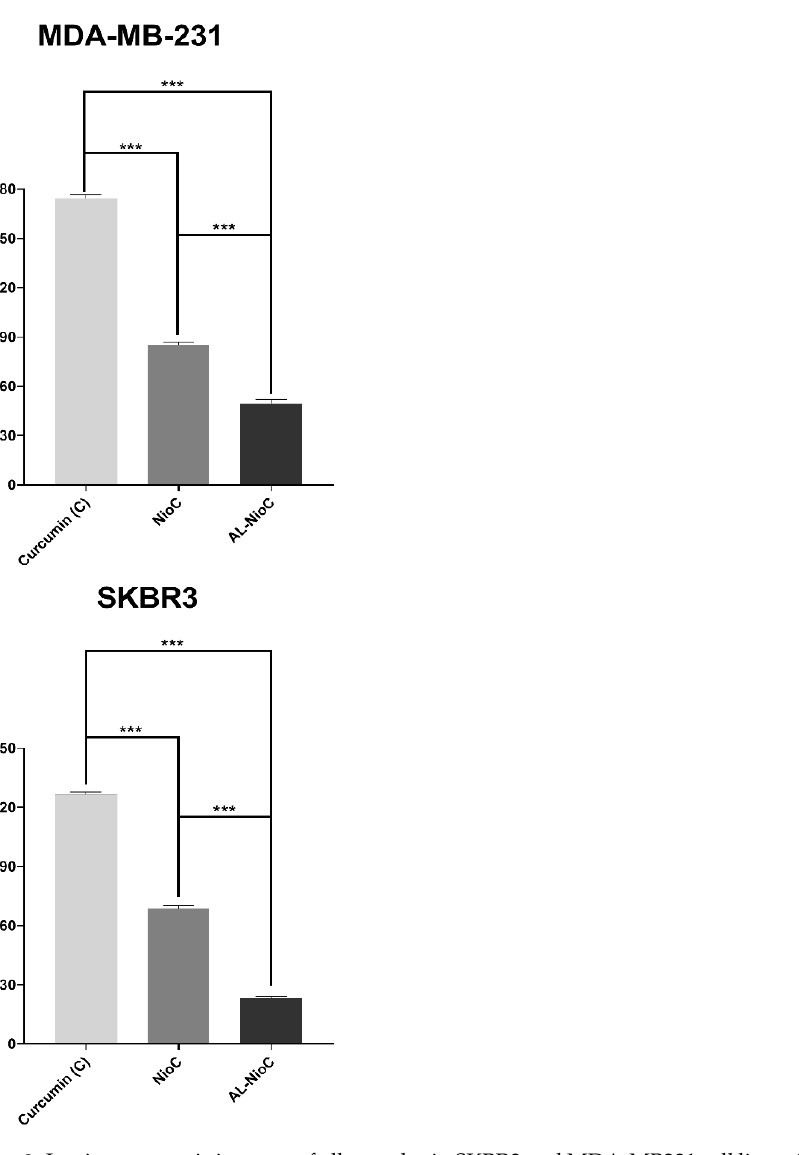
Figure 8. In vitro cytotoxic impacts of all samples in SKBR3 and MDA-MB231 cell lines; (*** p <